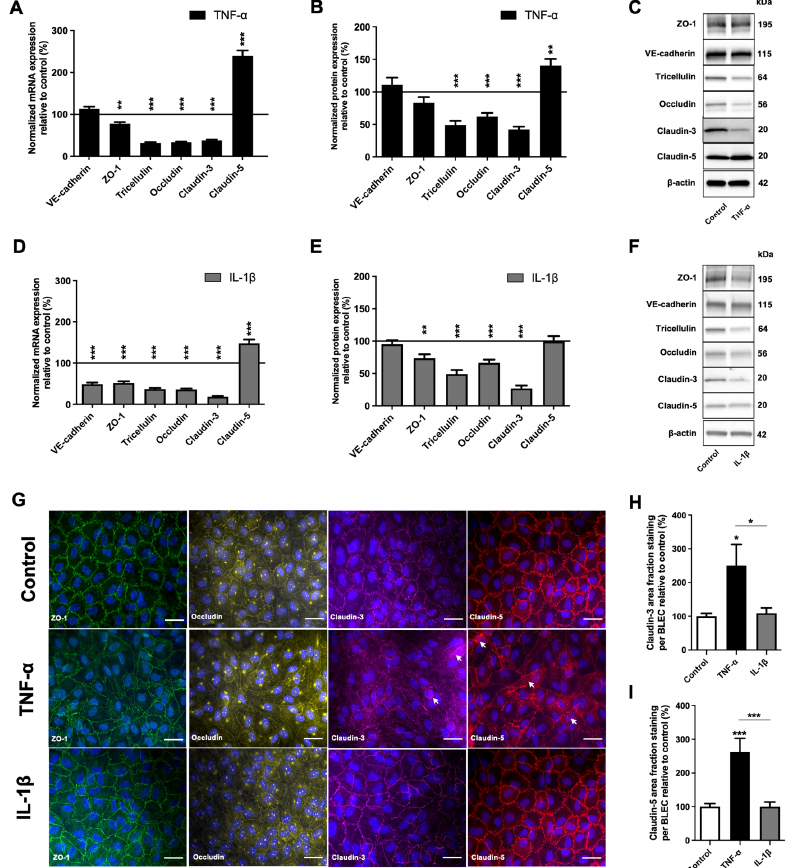
Figure 3. Effects of TNF- α or IL-1 β treatments on the expression and the localization of junctional protein in BLECs. ( A – C ) After 24 h of 10 ng.mL − 1 TNF- α treatment, mRNA ( A ) and protein level ( B ) of the major protein actors involved in the BBB physical integrity (tight junction protein: ZO-1, tri- cellulin, occludin, claudin-3, claudin-5; adherent junction protein: VE-cadherin) were determined by RT-qPCR and Western immunoblotting, respectively, compared to the control condition. ( C ) The immunoblotting images are representative of at least three independent experiments. ( D – F ) As in the above study, after a treatment of 10 ng.mL − 1 IL-1 β over 24 h, the mRNA ( D ) and protein levels ( E , F ) of the same targets were also quantified compared to the control condition. For each of the above graphs ( A , B , D , E ), the black lines correspond to the control condition value set at 100%. ( F ) The immunoblotting images are representative of at least three independent experiments. ( G ) Stain- ing of ZO-1 (green), occludin (yellow), claudin-3 (magenta) and claudin-5 (red) were obtained using immunofluorescence. Each white arrow indicates the presence of stain cytoplasmic dot. Nuclei ap- pear in blue. Scale bar: 50 μ m. ( H ) Claudin − 3 and ( I ) claudin-5 area fraction stainings were quanti- fied in BLECs after exposure to TNF- α or IL-1 β and were compared to respective control conditions. For all the above graphs, each bar is representative of at least three independent experiments per- formed in triplicate. Each bar represents the mean ± SEM relative to the control. The unpaired t test was used for mRNA study, while Mann–Whitney t-test was used for protein study. The threshold